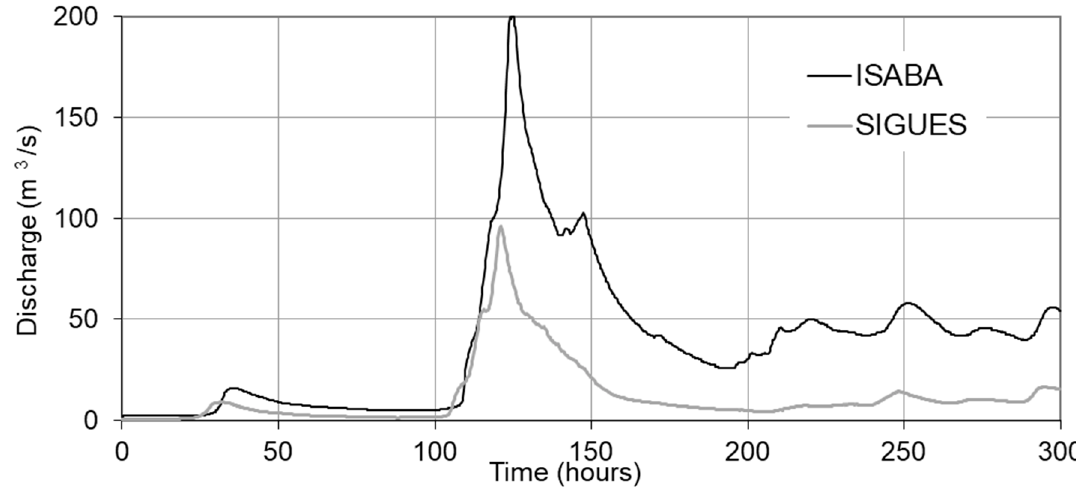
Figure 9. Actual hydrographs obtained from the Isaba (A268) and Sigues (A063) stations.